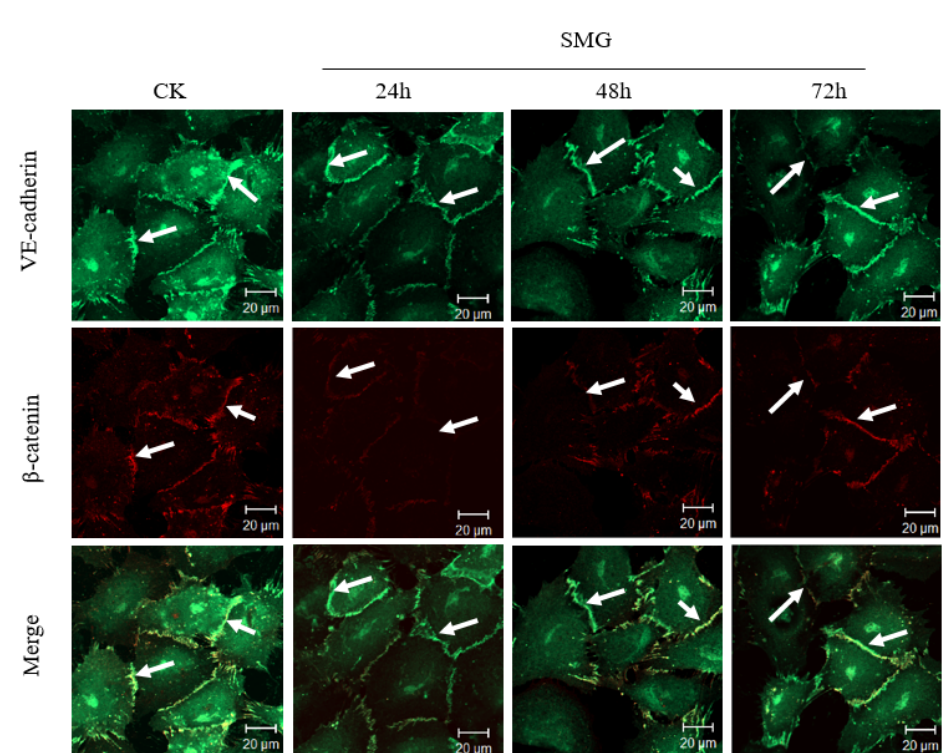
Figure 6. The expression of VE-cadherin and β -catenin was down-regulated under SMG. ( a )The total proteins were isolated from HUVEC cells treated with SMG, and expression of β -catenin and VE-cadherin protein was detected by Western blot with anti- β -catenin or anti-VE-cadherin anti- body, respectively. ( b , c ) The relative expression of β -catenin and VE-cadherin under SMG for 24, 48, and 72 h was calculated based on intense assay of each band of protein. The statistical results shown represent the means ( n = 3) vs. the control group ( n = 3); * p < 0.05, ** p < 0.01.